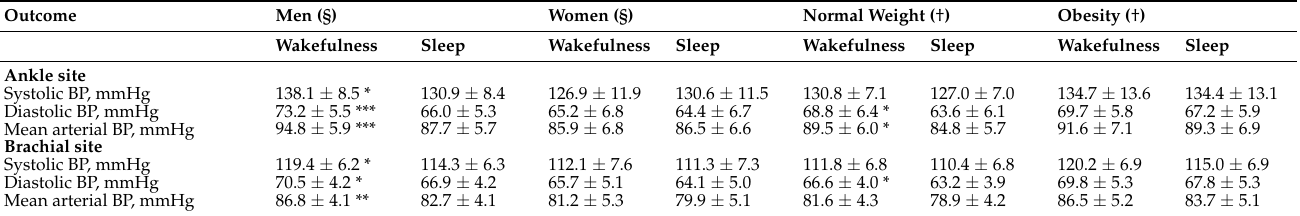
Table 2. Effects of one night of forced wakefulness on morning blood pressure, split by participants’ sex and weight group